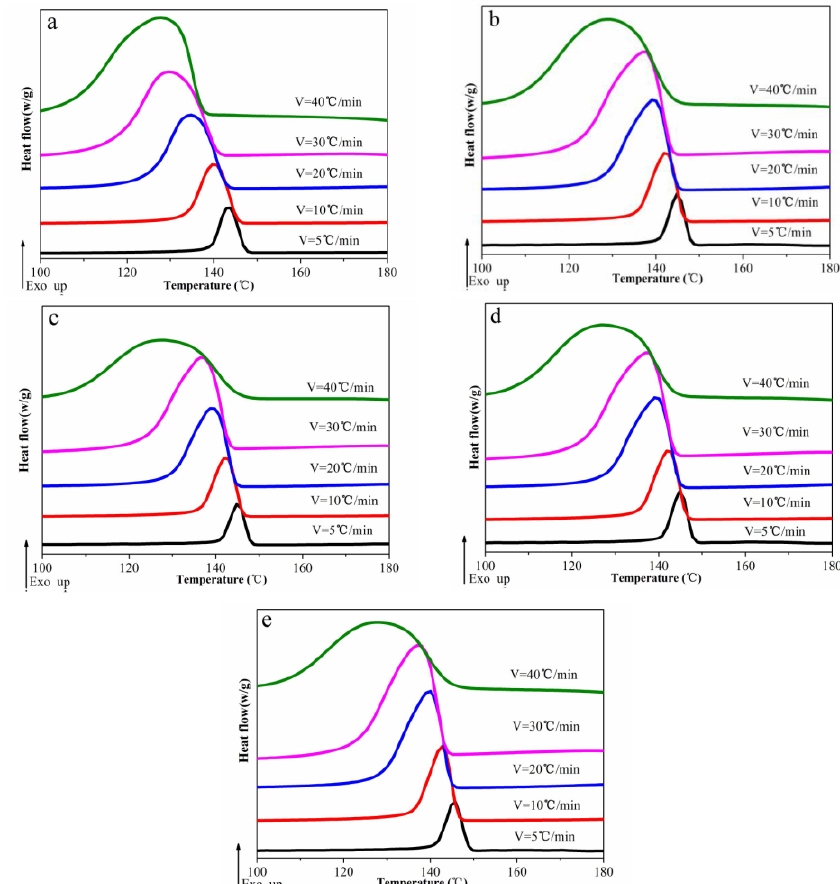
Figure 5. DSC cooling scan curves of POM/Ag nanocomposites with different Ag nanoparticle contents: ( a ) 0, ( b ) 0.1, ( c ) 0.5, ( d ) 1, ( e ) 2 wt % at the cooling rates of 5, 10, 20, 30 and 40 °C/min. Table 1. Characteristic crystallization peak temperatures. Enthalpy and degree of crystallinity values of samples crystallized with the cooling rate of 10 °C/min.